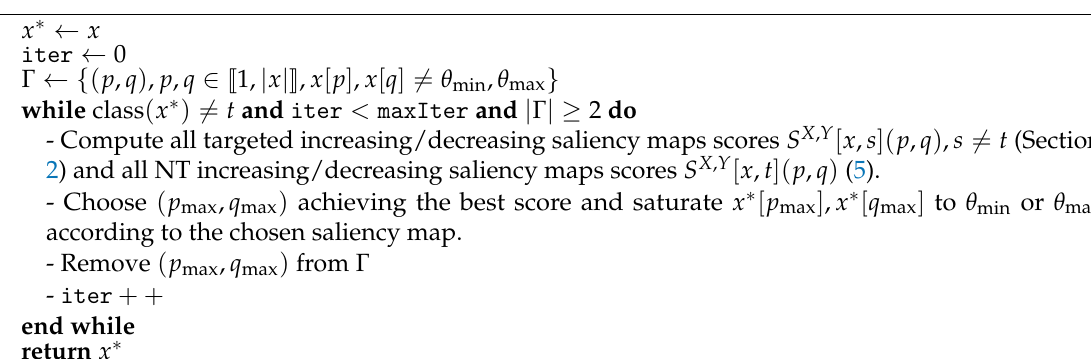
Algorithm 4 M-WJSMA and M-TJSMA